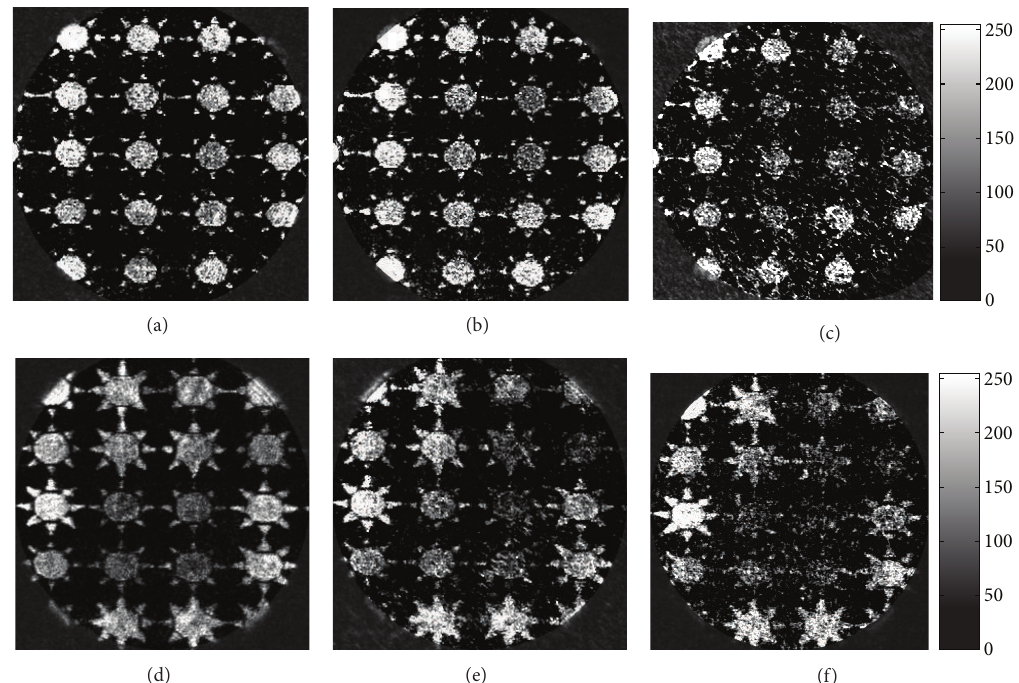
Figure 7: Object of SUN: ((a), (b), and (c)) images of the holograms numbers 1, 5, and 15, respectively, stored with BIM. ((d), (e), and (f)) Images of the holograms numbers 1, 5, and 15, respectively, stored with